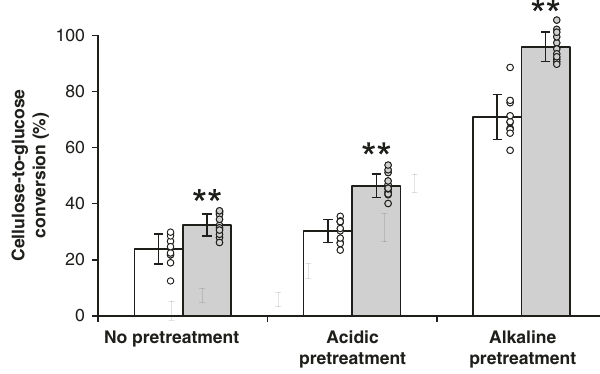
Fig. 4 Sacchari fi cation assays of CCR2 ( − /*) line 12 stems. Plants were grown for 20 weeks in the greenhouse. Cellulose-to-glucose conversion ef fi ciencies of wild type and CCR2 ( − /*) line 12 were calculated based on the quanti fi ed amounts of cellulose and the amount of released glucose after 72 h of sacchari fi cation following no pretreatment, acidic pretreatment (1 M HCl), or alkaline pretreatment (62.5 mM NaOH) (Supplementary Table 3, Table 1). Individual values (dots) and means (bars) of 10 biologically independent samples for wild type (white bars) and eleven biologically independent samples for CCR2 ( − /*) line 12 (gray